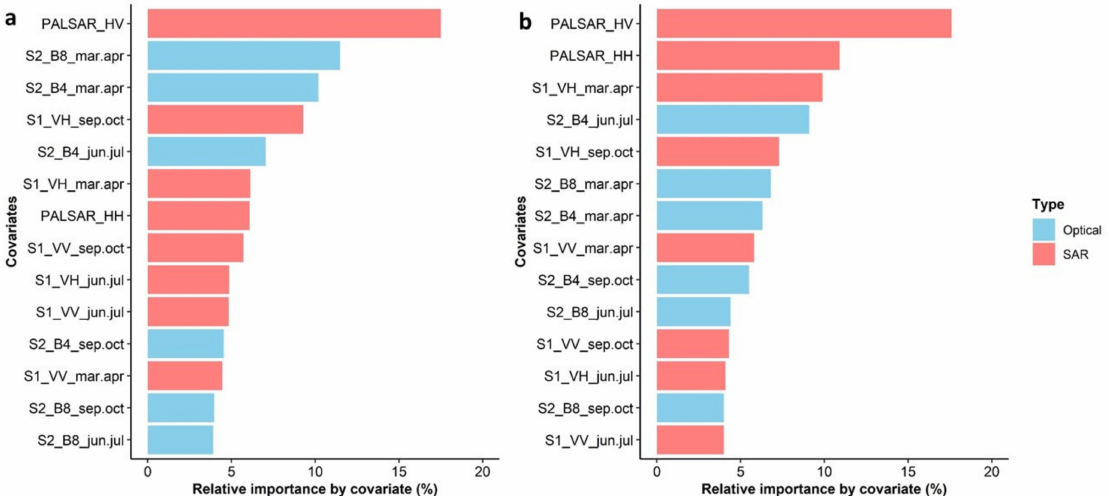
Figure 3. Ranking of variable importance generated by the random forest algorithm. ( a ) Ranking with relative importance of covariates when modeling canopy height using ICESat-2 data. ( b ) Ranking relative importance of covariates when modeling canopy height using GEDI